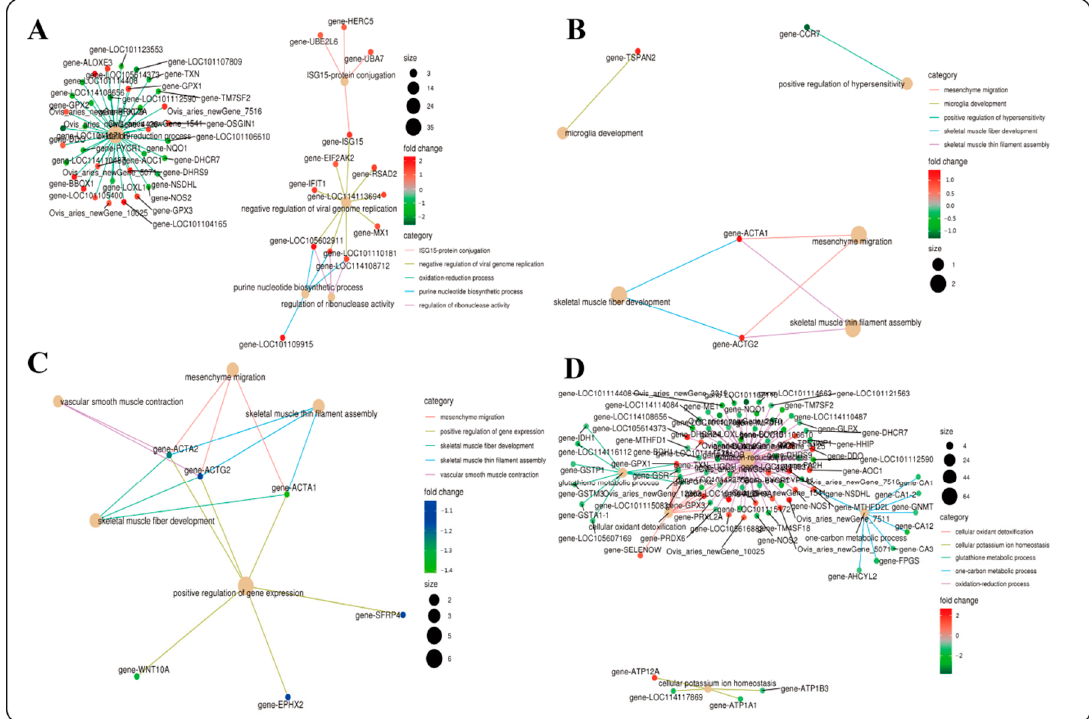
Figure 5. BP functional enrichment diagram. ( A ): 4 months_vs._1.5 years; ( B ): 1.5 years_vs._3.5 years; ( C ): 3.5 years_vs._6 years; ( D ): 4 months_vs._6 years. Note: The red dots represent upregulated genes, and the green dots represent downregulated genes.